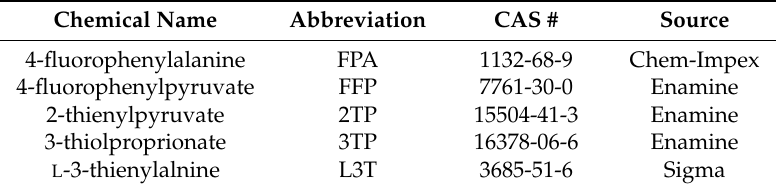
Table 1. List of phenylalanine-related drugs used.